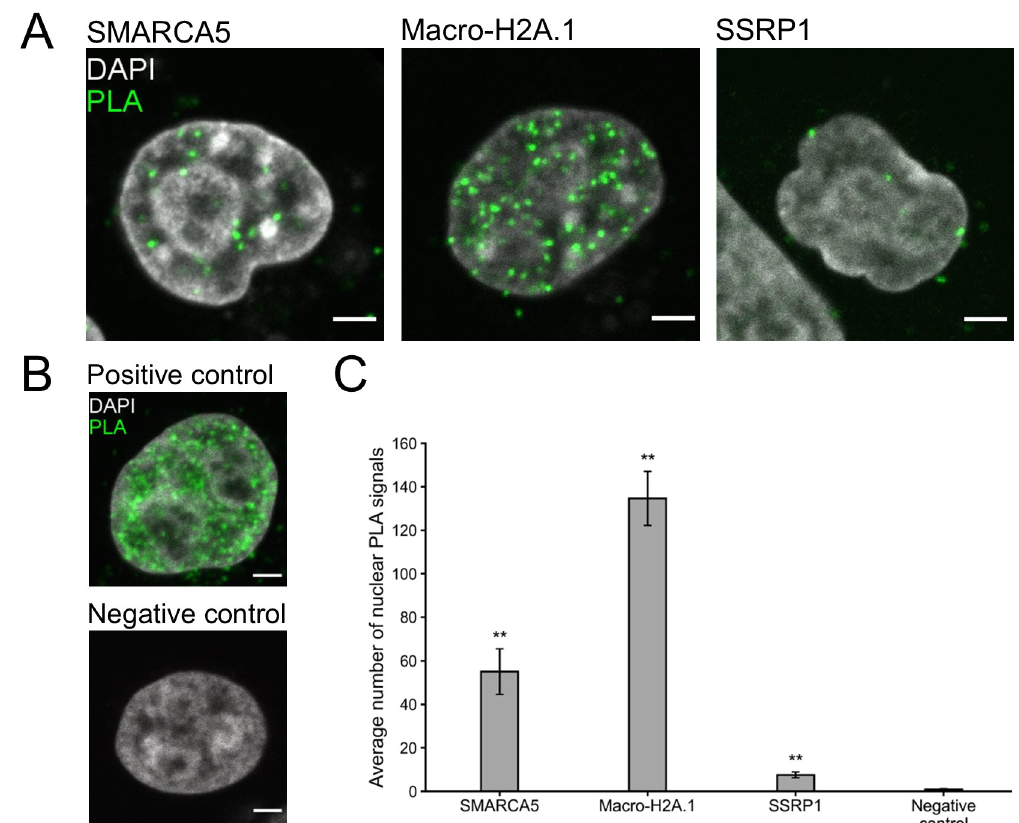
Fig 5. Close proximity analysis verifies the association of NS2 with key BioID interactors. Proximity Ligation Assay (PLA) assay was performed in HeLa cells transfected with NS2-EGFP and representative cellular proteins identified by BioID. The proteins were chromatin remodeling factor (SMARCA5), transcriptional repressor (macro-H2A.1), and histone chaperon of the FACT complex (SSRP1). ( A ) Representative single confocal cross-sections showing the localization of PLA signals (green) and the nuclei stained with DAPI (gray). ( B ) Positive and negative controls include PLA with antibodies against VP2 capsid protein and intact capsids in infected cells at 20 hpi and in noninfected cells. Scale bars, 3 μ m. ( C ) The graph shows the average number of PLA signal foci per nucleus (n = 15) analyzed from 3D reconstructions of confocal images. The error bars show the standard error of the mean (SEM), and the samples having a significantly higher number of nuclear PLA foci compared to the negative control are denoted as �� (p < 0.01). The significance was assessed using Poisson regression model.